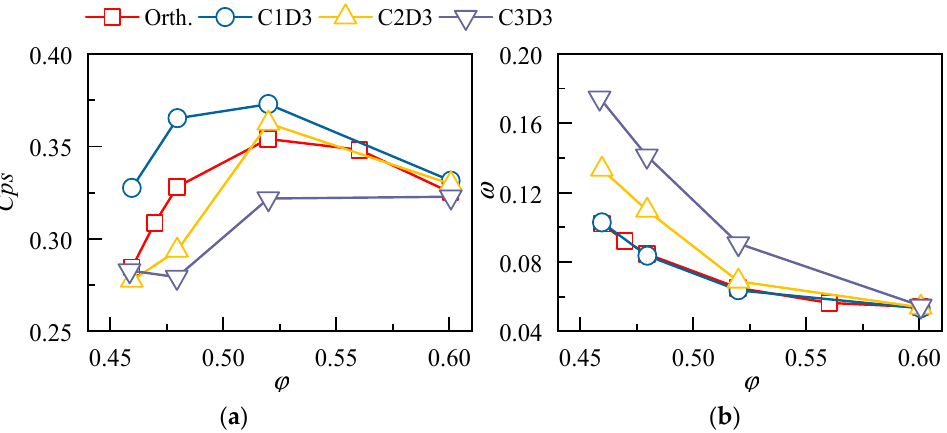
Figure 15. Pressure rise and loss characteristics for the stator with different dihedral heights. ( a ) Pressure rise and ( b ) loss.